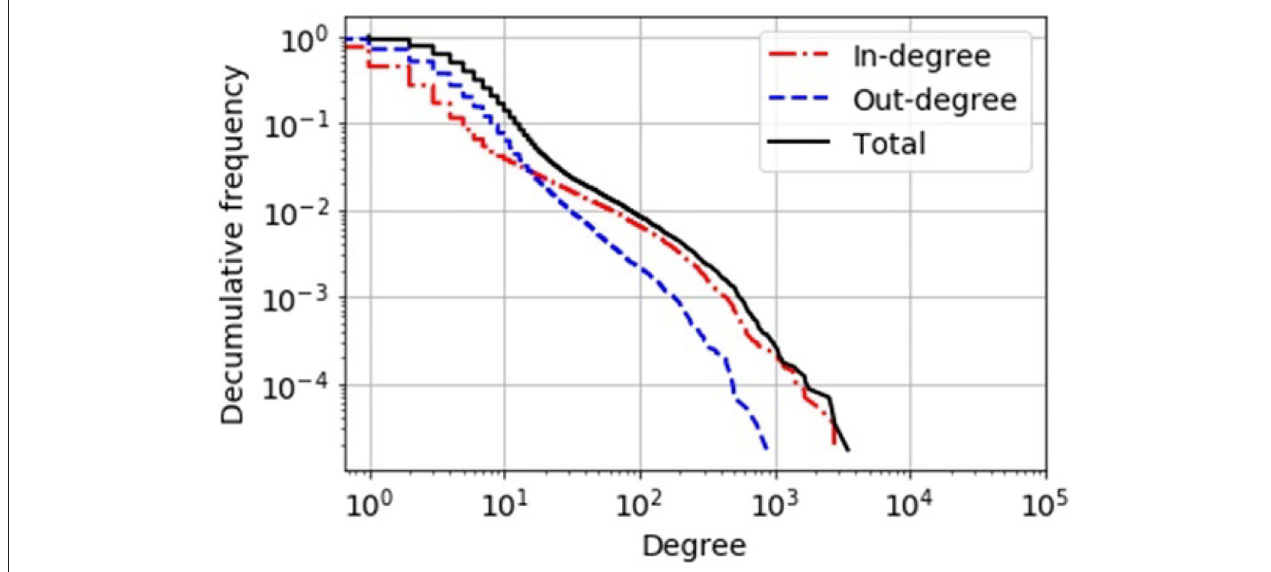
FIGURE 1 | Decumulative degree distribution of the static network view of the German pig trade. In-degree, number of different suppliers of a holding; out-degree, number of different customers of a holding. By comparison, a simple “scale-free” network topology would have a power-law-shaped distribution that would appear as a linear curve in this double-logarithmic plot.